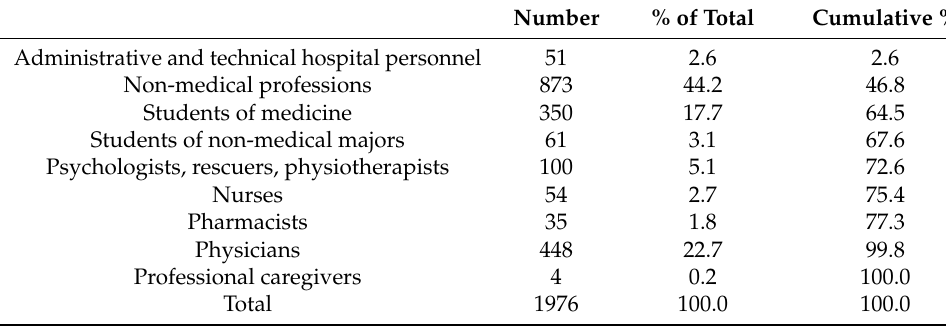
Table 1. Professions of the surveyed